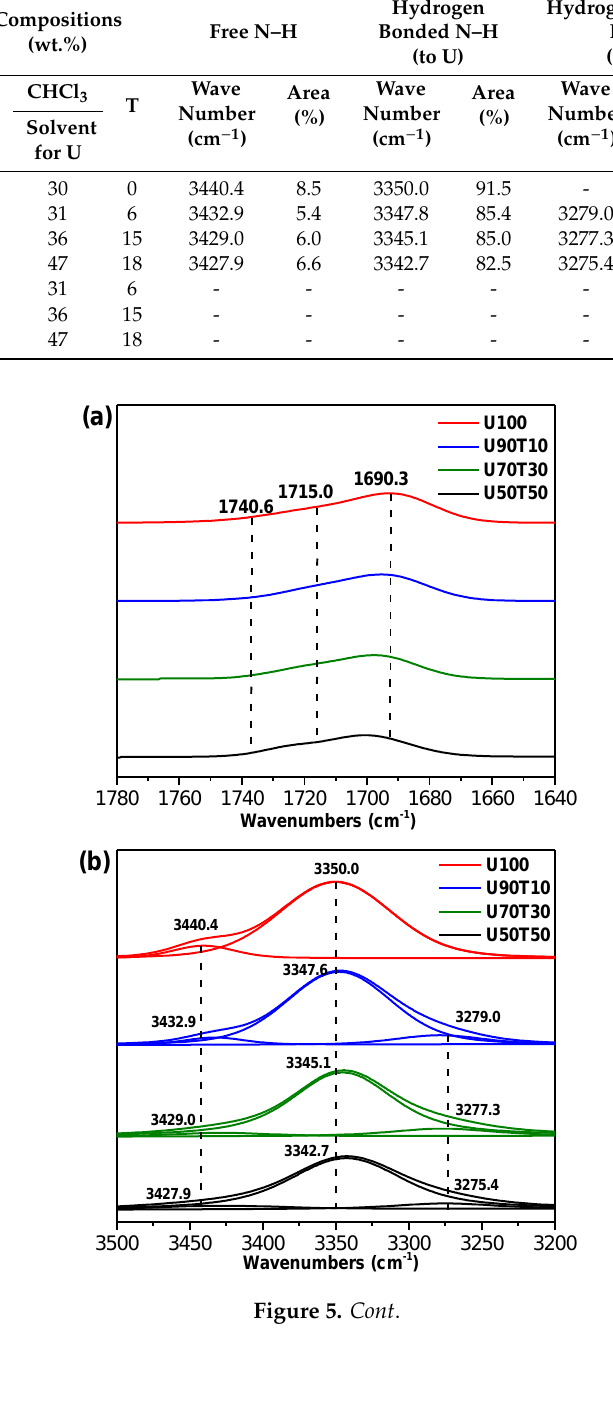
Figure 5. ( a ) The C=O stretching regions of the U and UT blends, ( b ) the N-H stretching regions of the U and UT blends, and ( c ) the C=O stretching regions of the UT blends and UE blends in the FT-IR spectra. Each spectrum in (b) was resolved into its components by the curve-fitting method. To analyze the FT-IR results quantitatively, the N – H bands were deconvoluted by fitting with mixed Lorentzian – Gaussian shaped components as shown in Figure 5b. The U100 spectrum initially contained the band of free N – H at 3440.4 cm − 1 and the band of the N – H hydrogen bonded to U at 3350.0 cm − 1 as listed in Table 3. When T was added to U, a new peak associated with the band of the N – H hydrogen bonded to T appeared due to the formation of stronger hydrogen bonding between U and T compared to that between two U molecules. As the weight fraction of T further increased, the peak position corresponding to the new peak shifted to lower wavenumbers. In addition, the